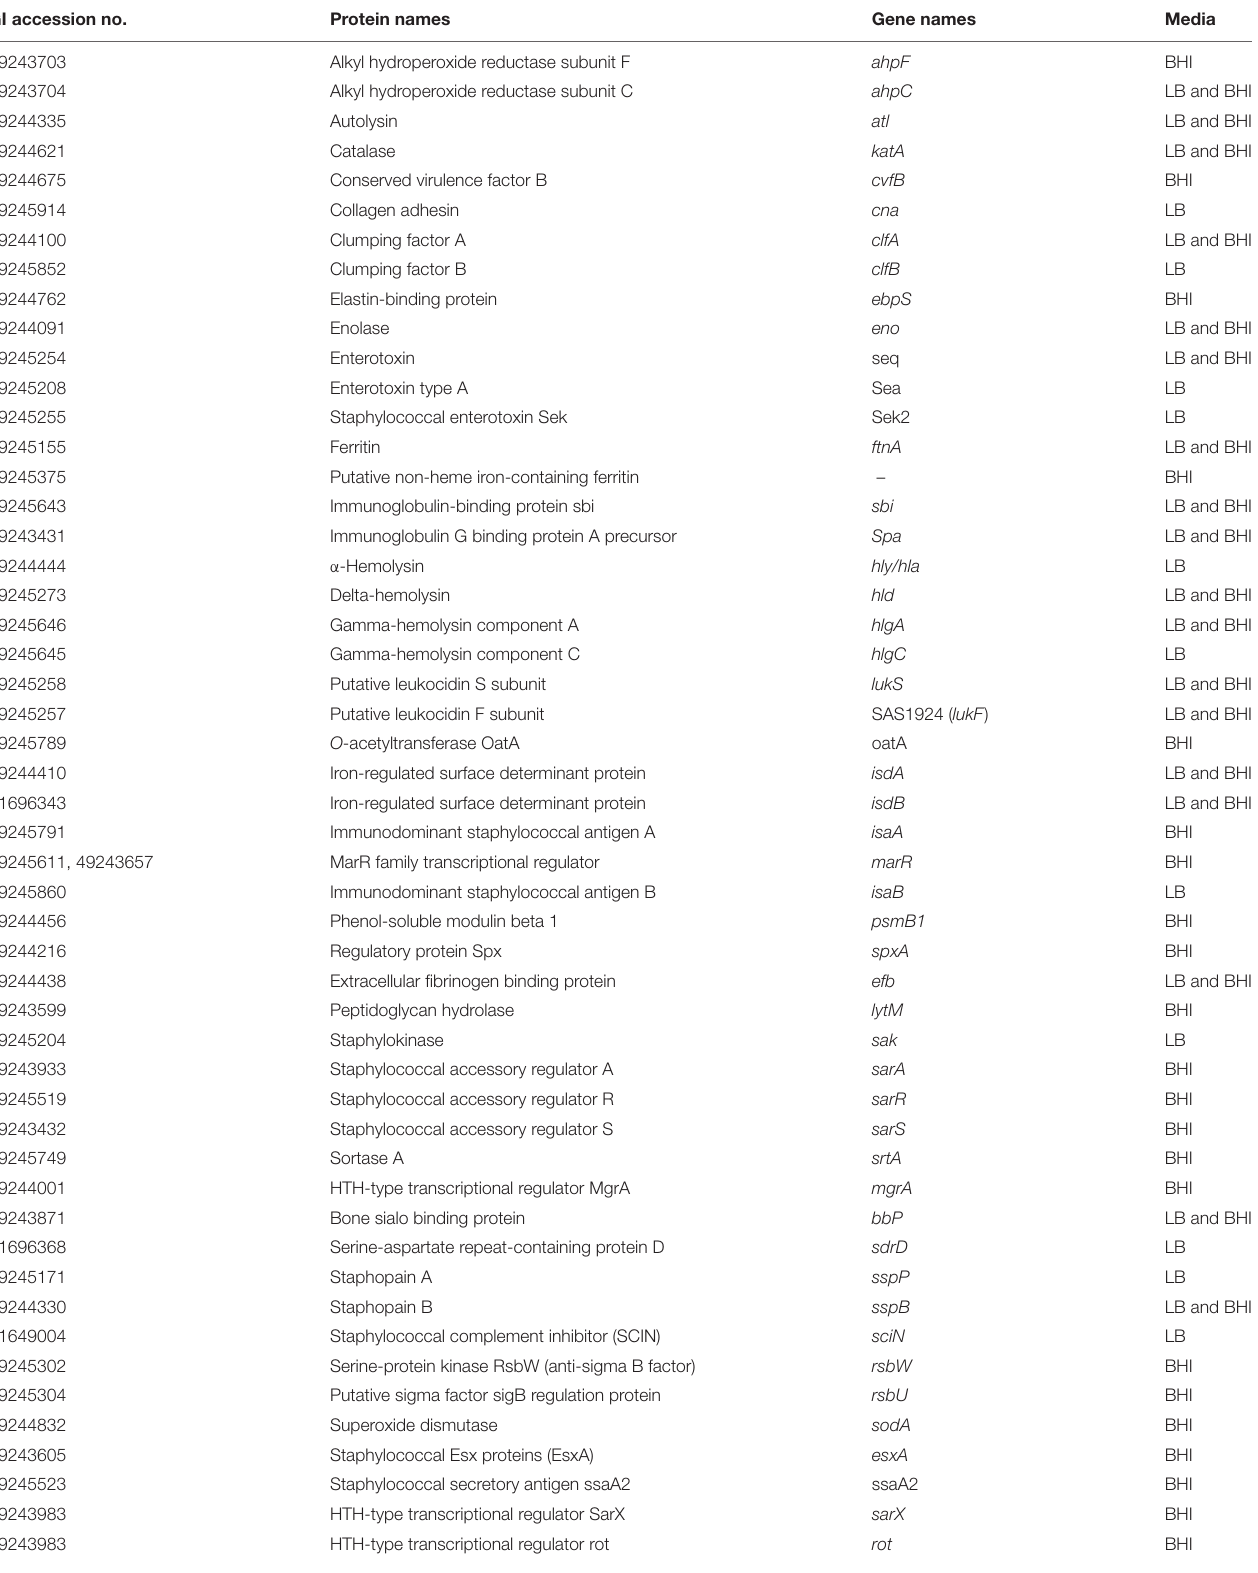
TABLE 1 | Virulence factors associated with MVs isolated from S. aureus grown in BHI and LB. GI accession